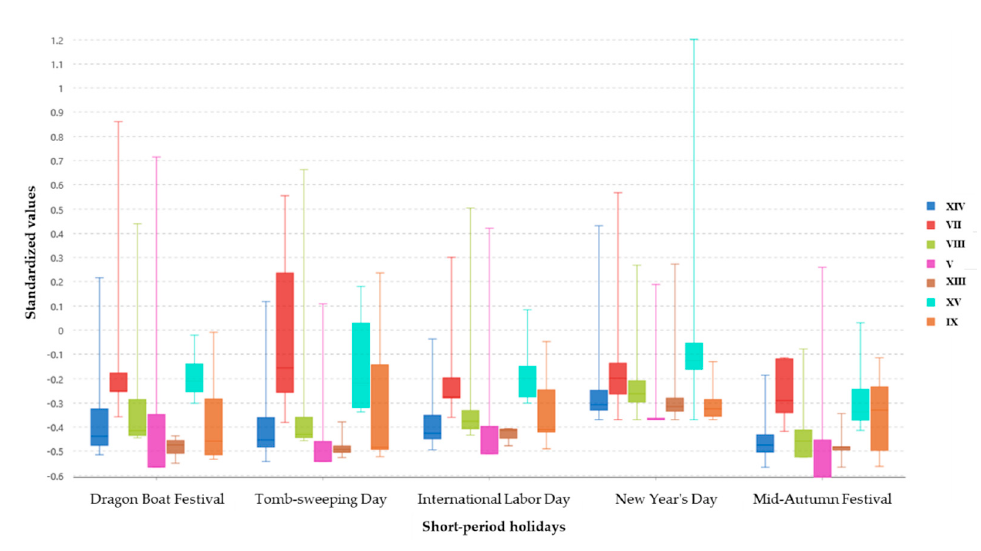
Figure 3. Side-by-side boxplots for regionalization results of cities in China.